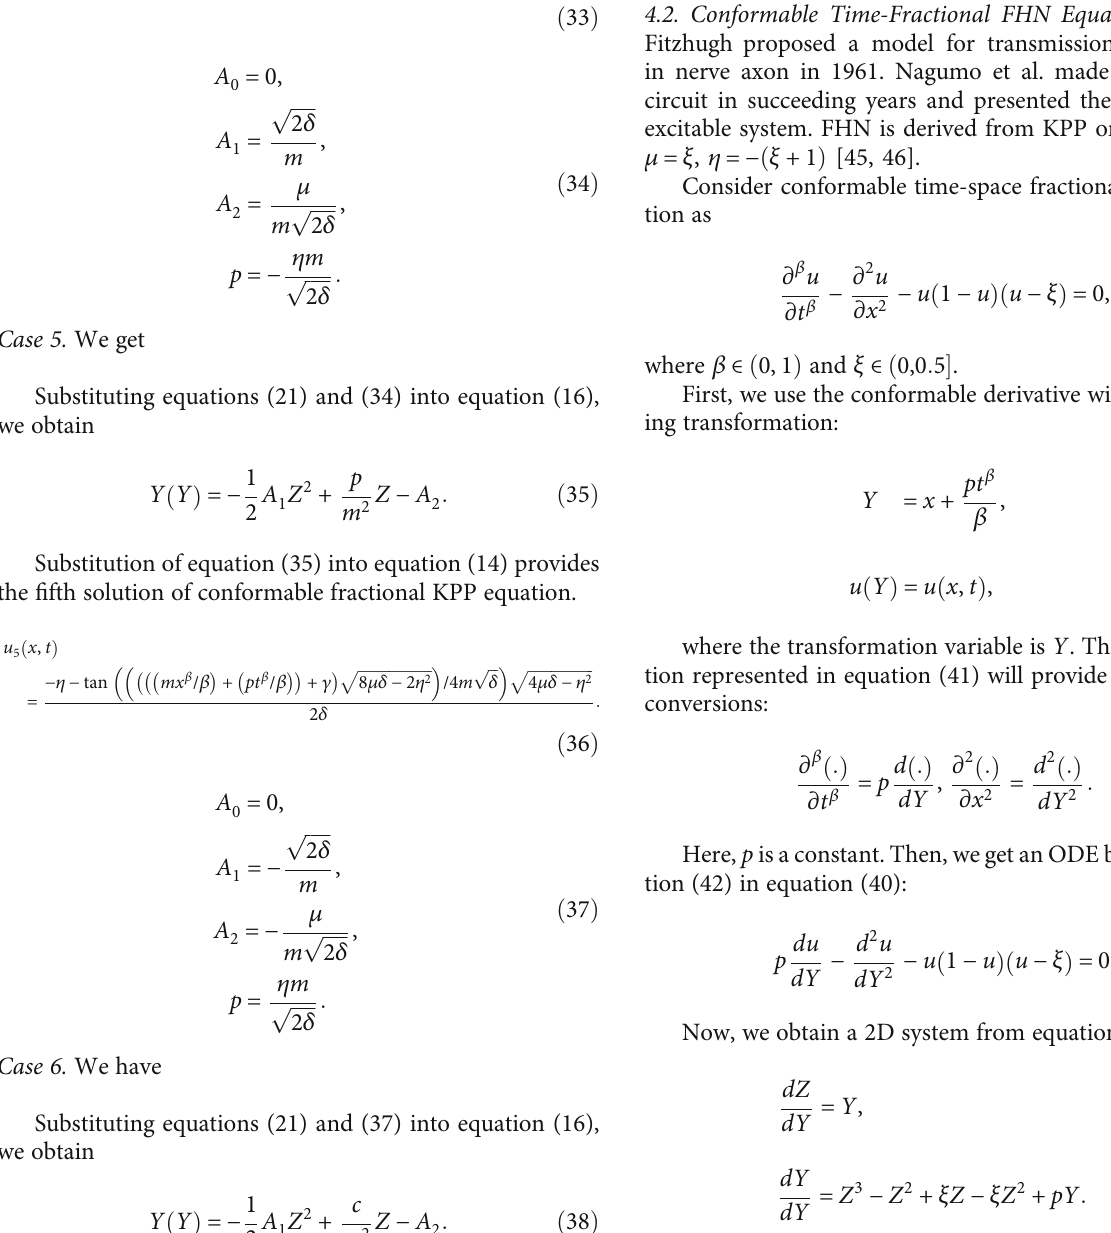
Figure 1. For larger values of β , the solutions attain more height which is depicted in Figure 2. Figure 3 shows the graphical presentation in 2D plot of genes for the KPP equa- tion. The graphical solutions of the KPP equation can be used in diallel analysis as observed in